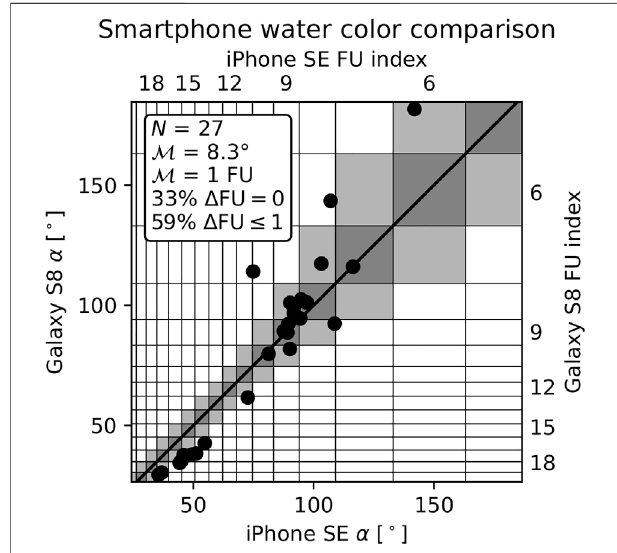
FIGURE 8 | Comparison between iPhone SE and Galaxy S8 measurements of hue angle and FU index. The solid line corresponds to a 1:1 relation. The dark gray squares indicate a full FU match, the light gray ones a near-match. Accurate uncertainties on individual points could not be determined ( Section 2.4 ). The statistics in the text box are based on a 1:1